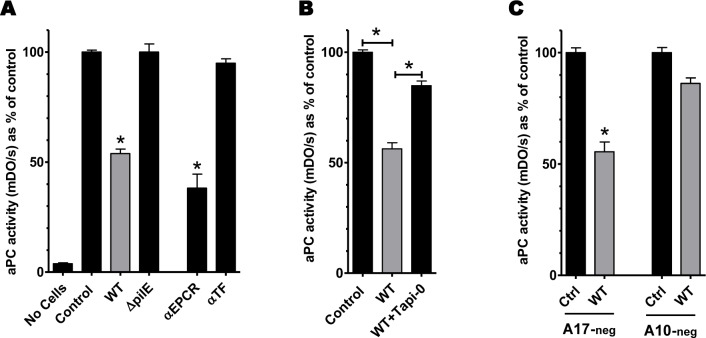
aPC generation by endothelial cells is impaired upon infection by N. meningitidis.After infection or antibody treatment, endothelial cells were washed and incubated for 30 min with Protein C and thrombin. The amount of aPC generated was determined through its proteolytic activity against a chromogenic substrate. The same experimental procedure was applied to an empty well without cells to assess the spontaneous degradation of the chromogenic substrate (no cells bar). (A) HDMEC were infected with either a wild type or ΔpilE strain for 4 hours. Cells were also treated for 10 minutes with an antibody blocking EPCR-PC interactions (clone RCR-252, 10 μg/mL) or a control antibody (directed against tissue factor, 10 μg/mL). Data are means (+/-SEM) of % of aPC activity compared to that of non-infected cells from 3 independent experiments. *:p<0.001 compared to control. (B) HDMEC cells were infected for 4 hours with a WT strain in the presence or absence of Tapi-0 (25μM). Data are means (+/-SEM) of % of aPC activity compared to that of non-infected cells from 3 independent experiments. (C) ADAM17-negative or ADAM10-negative hCMEC/D3 cells were infected for 4 hours with a WT strain. Data are means (+/-SEM) of % of aPC activity compared to that of non-infected cells from 3 independent experiments. *: p<0.0001 compared to control.